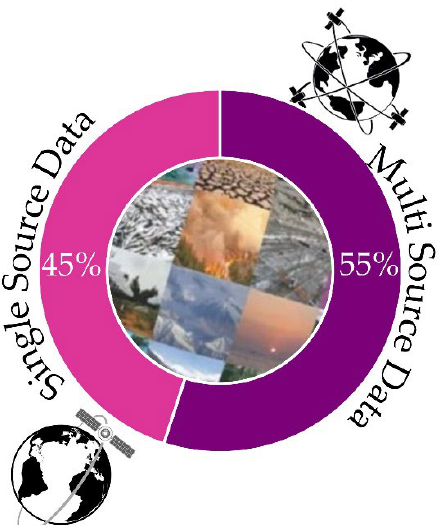
Figure 12. Frequency of single- and multi-source RS data usage in wetland studies.